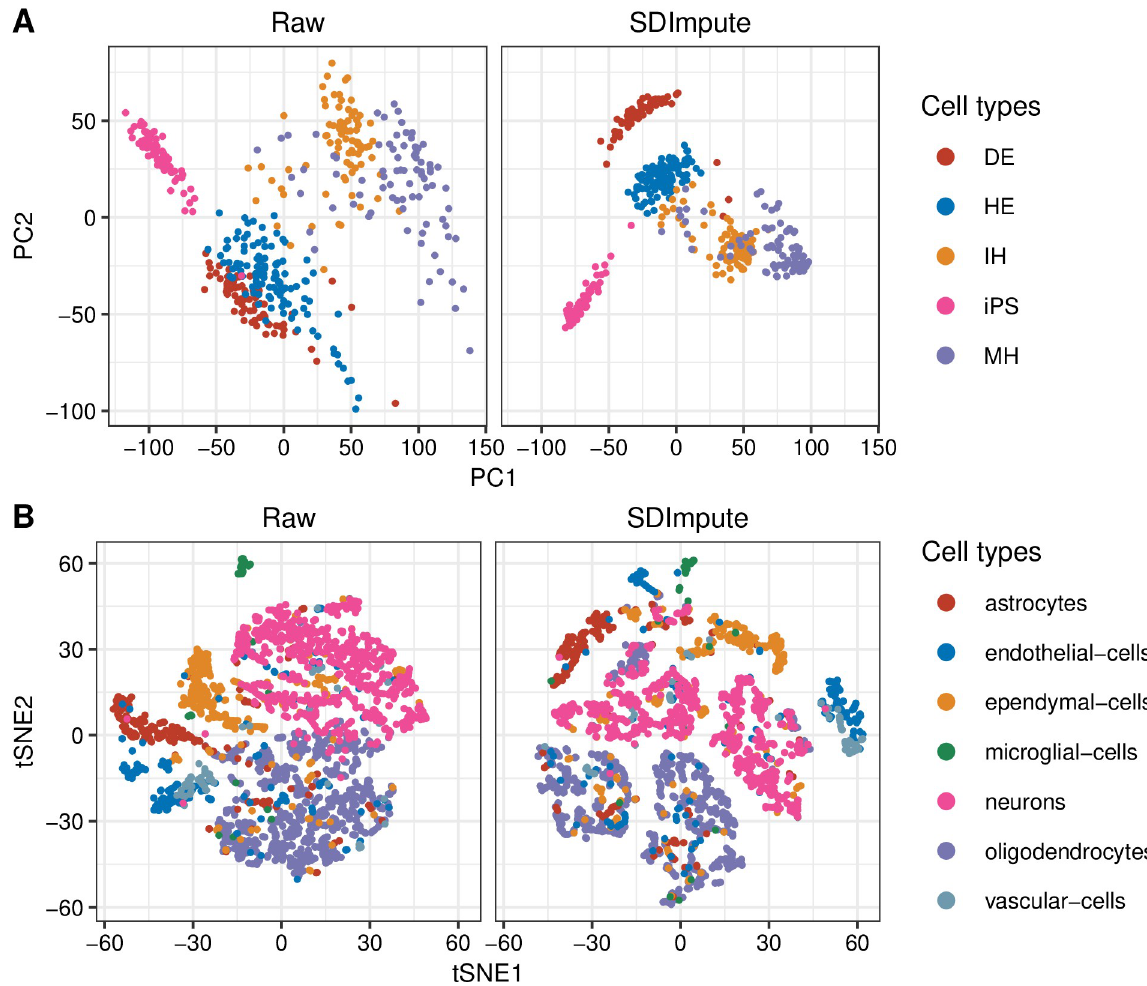
Fig 4. SDImpute improves the visualization of cell types in real datasets. (A) PCA plots in raw data and SDImpute imputed data of the Camp dataset. (B) t-SNE plots in raw data and SDImpute imputed data of the Romanov dataset.